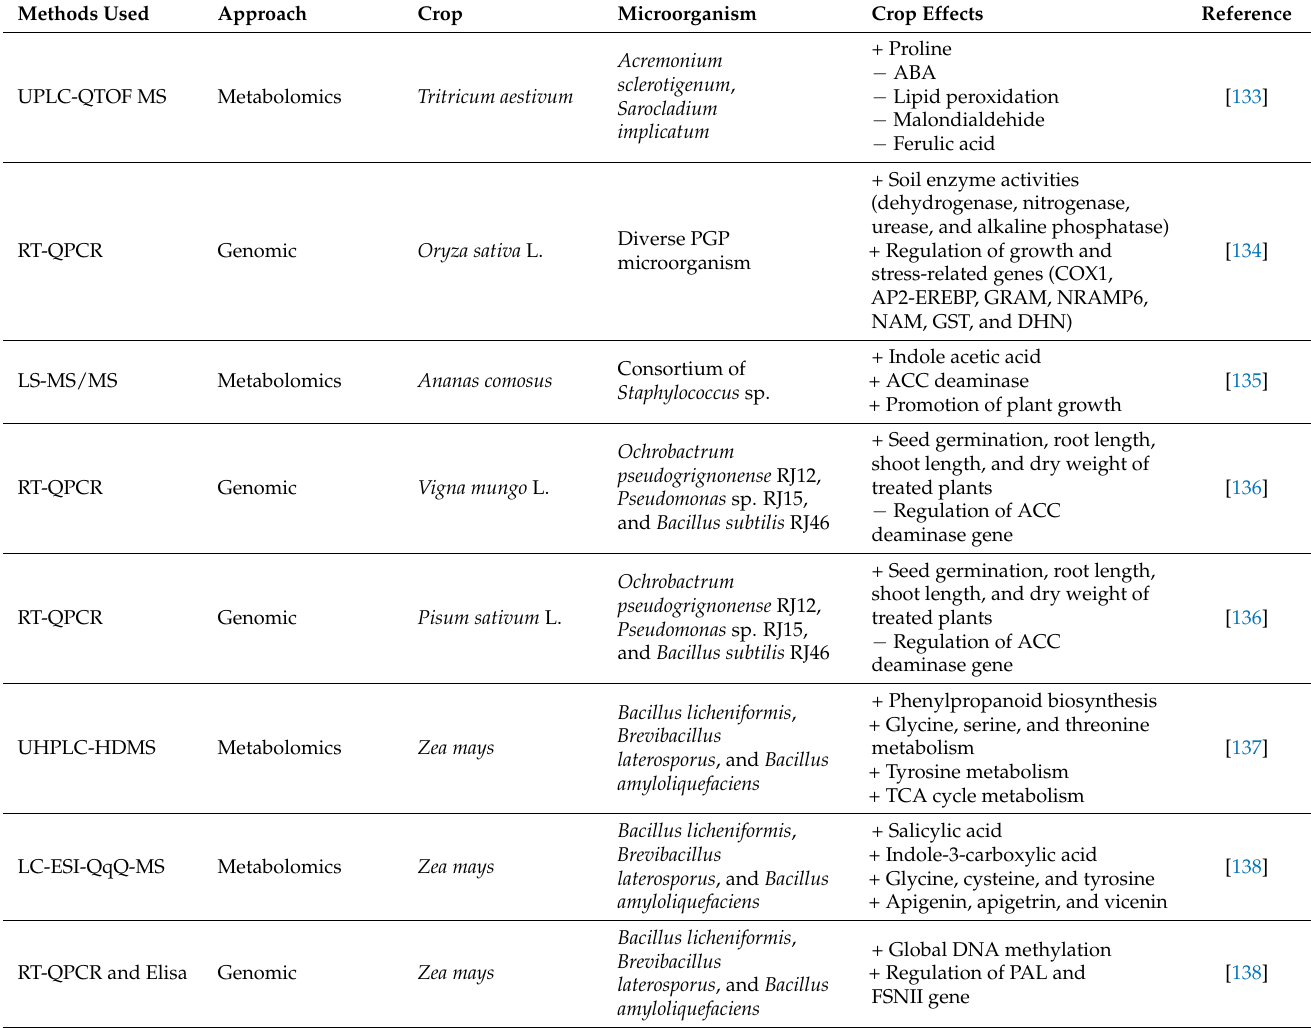
Table 3. Recent research regarding the use of PGP microorganisms and their effects on plant under drought stress through omics